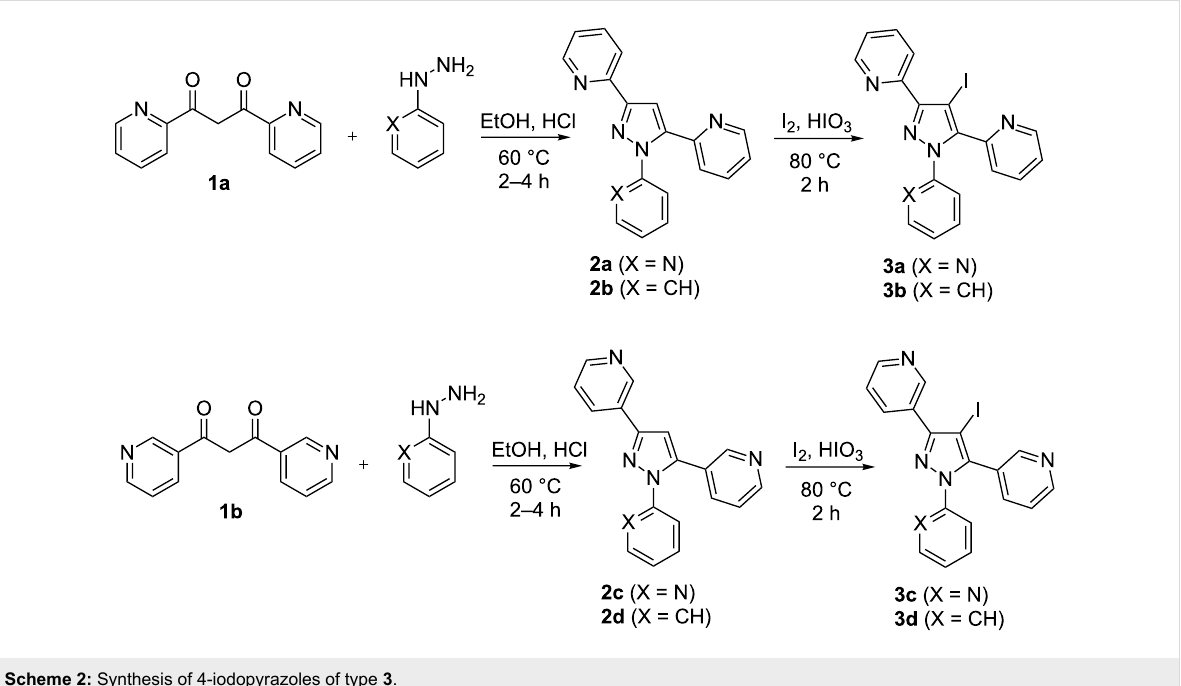
Scheme 2: Synthesis of 4-iodopyrazoles of type 3